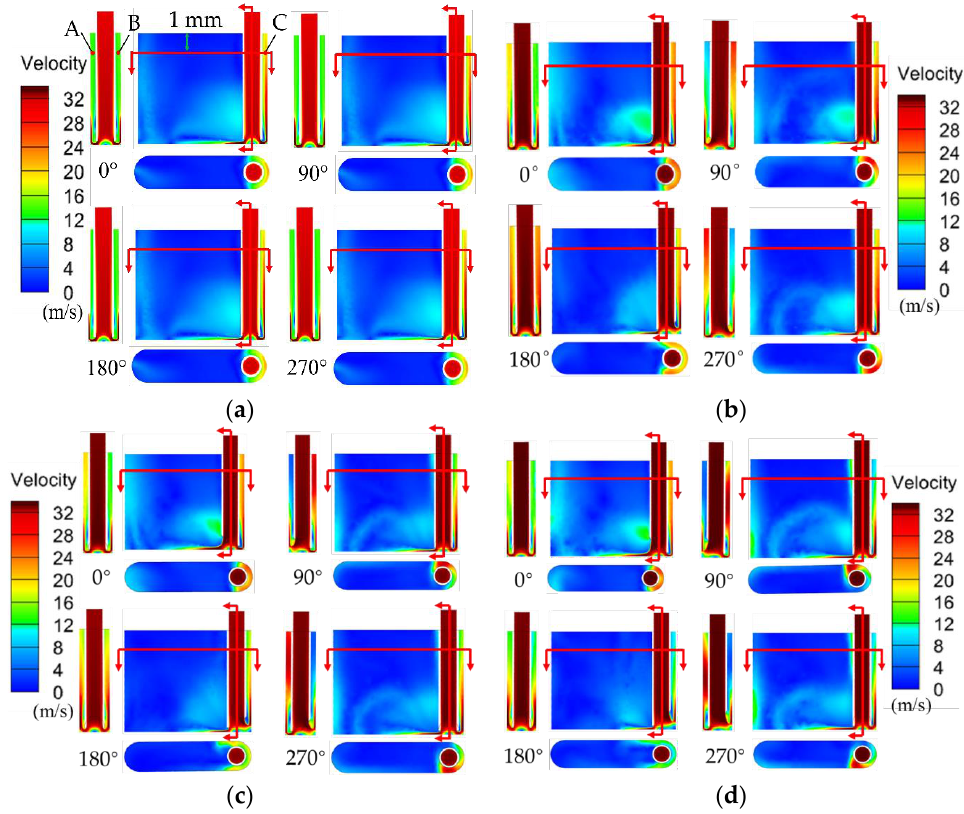
Figure 4. The contour of flow velocity on the cross section with different wedged angles in the end face of the tube tool. ( a ) 0°; ( b ) 40°; ( c ) 50°; ( d )